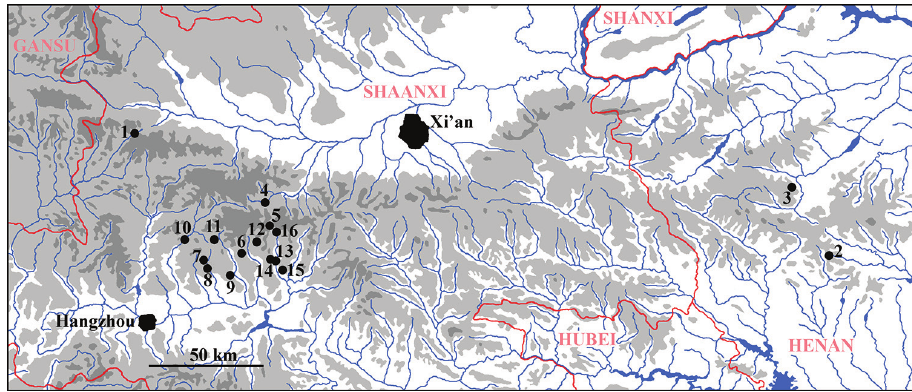
Figure 35. Known distribution of Amphinemurinae in the Qinling Mountains 1 Amphinemura lingulata , Mesonemoura membranosa 2 A. didyma , A. mamillata , Indonemoura auriformis , M. tritaenia 3 Sphaerone- moura separata 4 A. annulata , A. lingulata 5 A. annulata 6 A. dicroidea 7 A. longihamita , S.